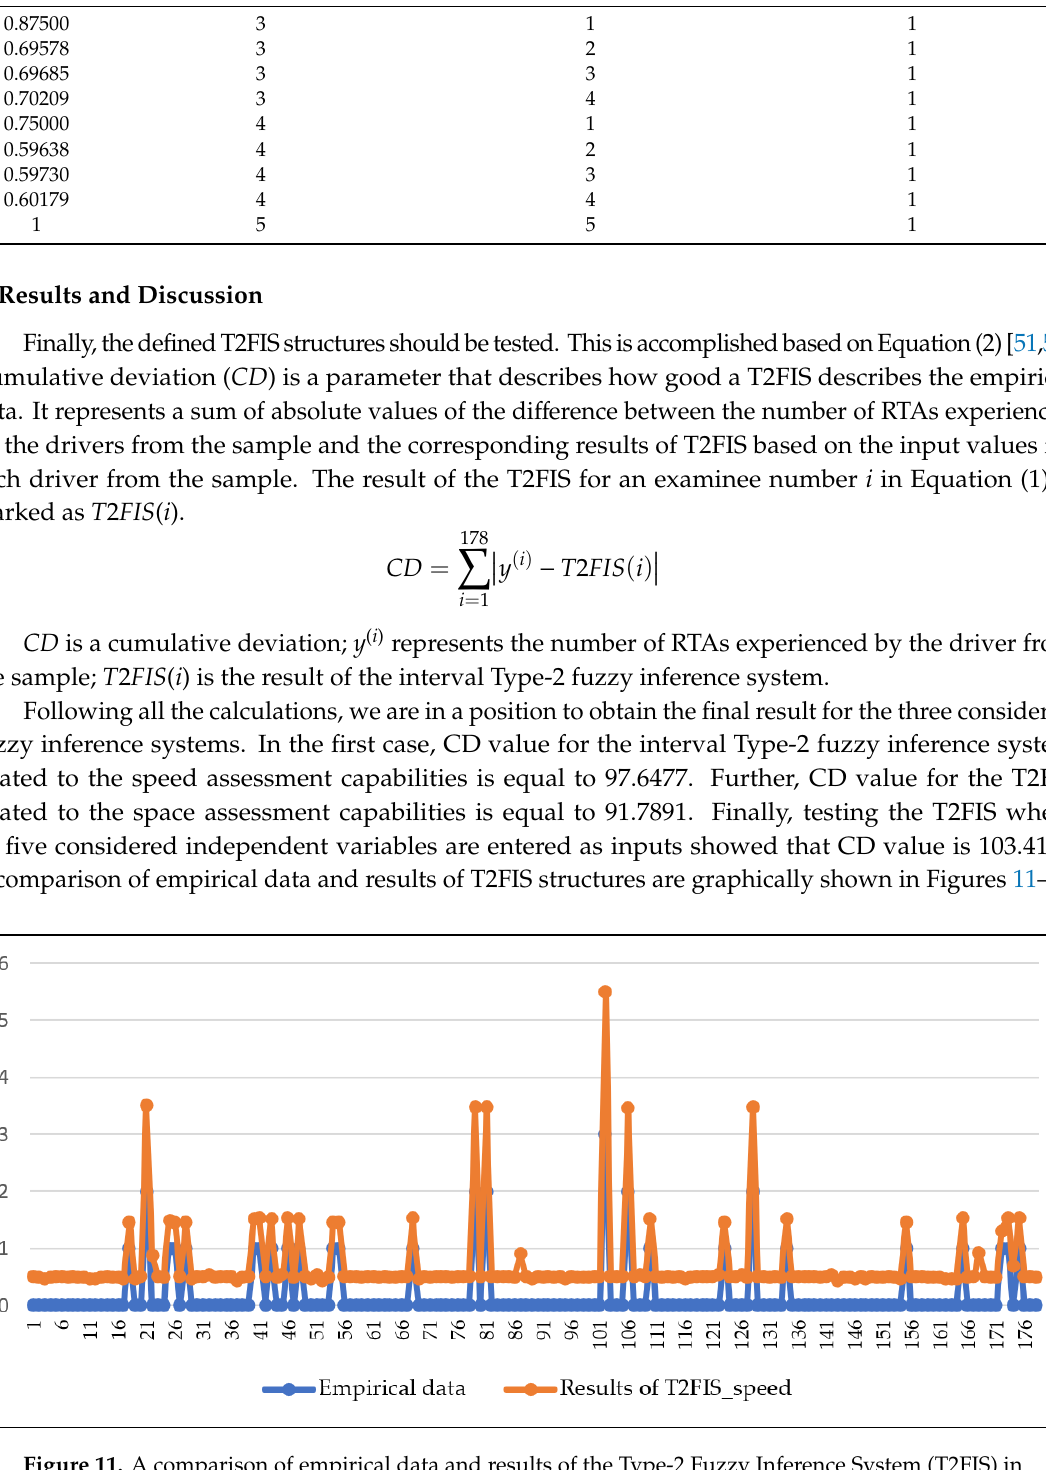
Figure 11. A comparison of empirical data and results of the Type-2 Fuzzy Inference System (T2FIS) in the case of speed capabilities assessment—T2FIS_speed.